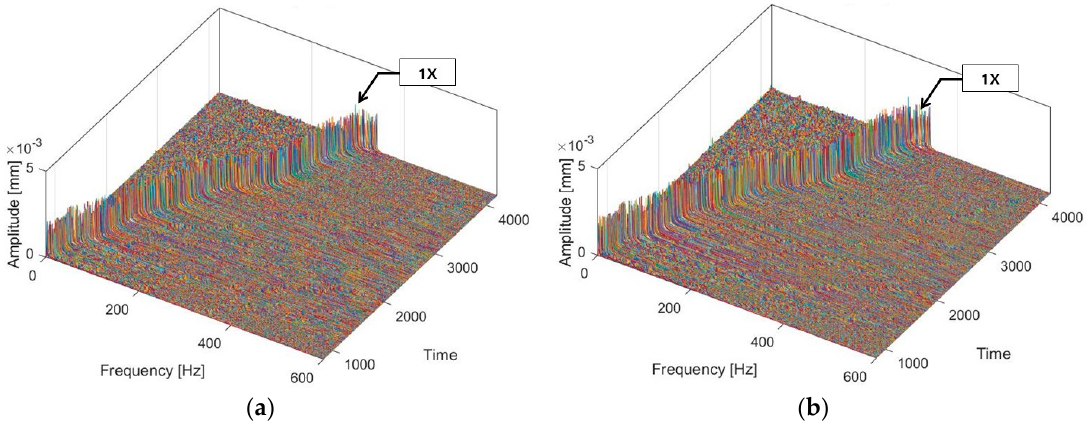
Figure 13. Rotor vibration measurement results. ( a ) x-direction; ( b ) y-direction.